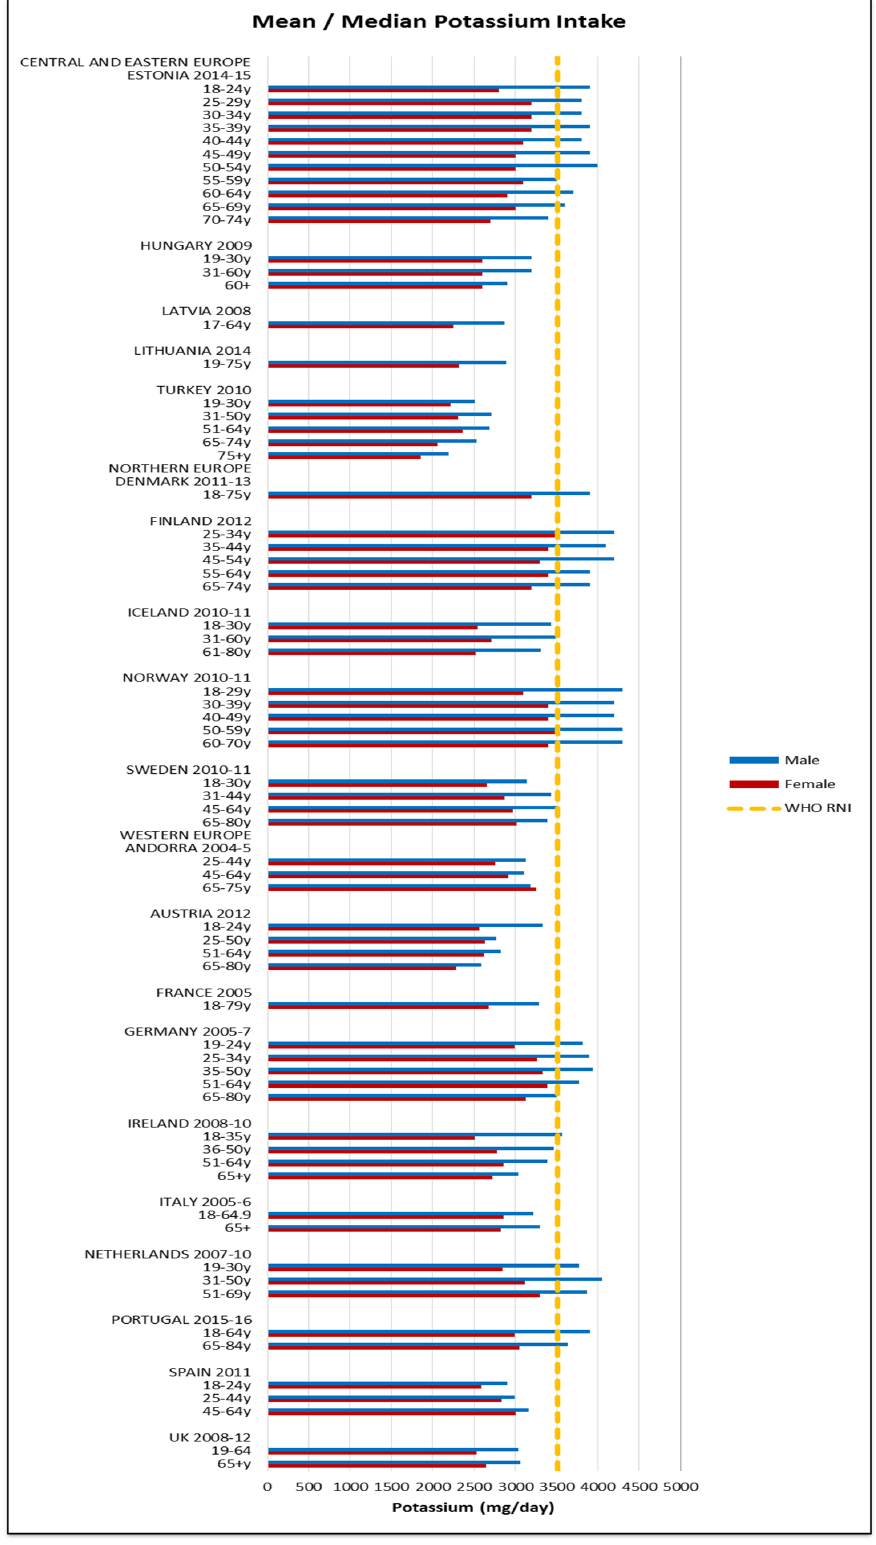
Figure 11. Mean/median* adult potassium intake (mg/day) (excluding supplements). * Figures for Spain are based on median rather than mean values.